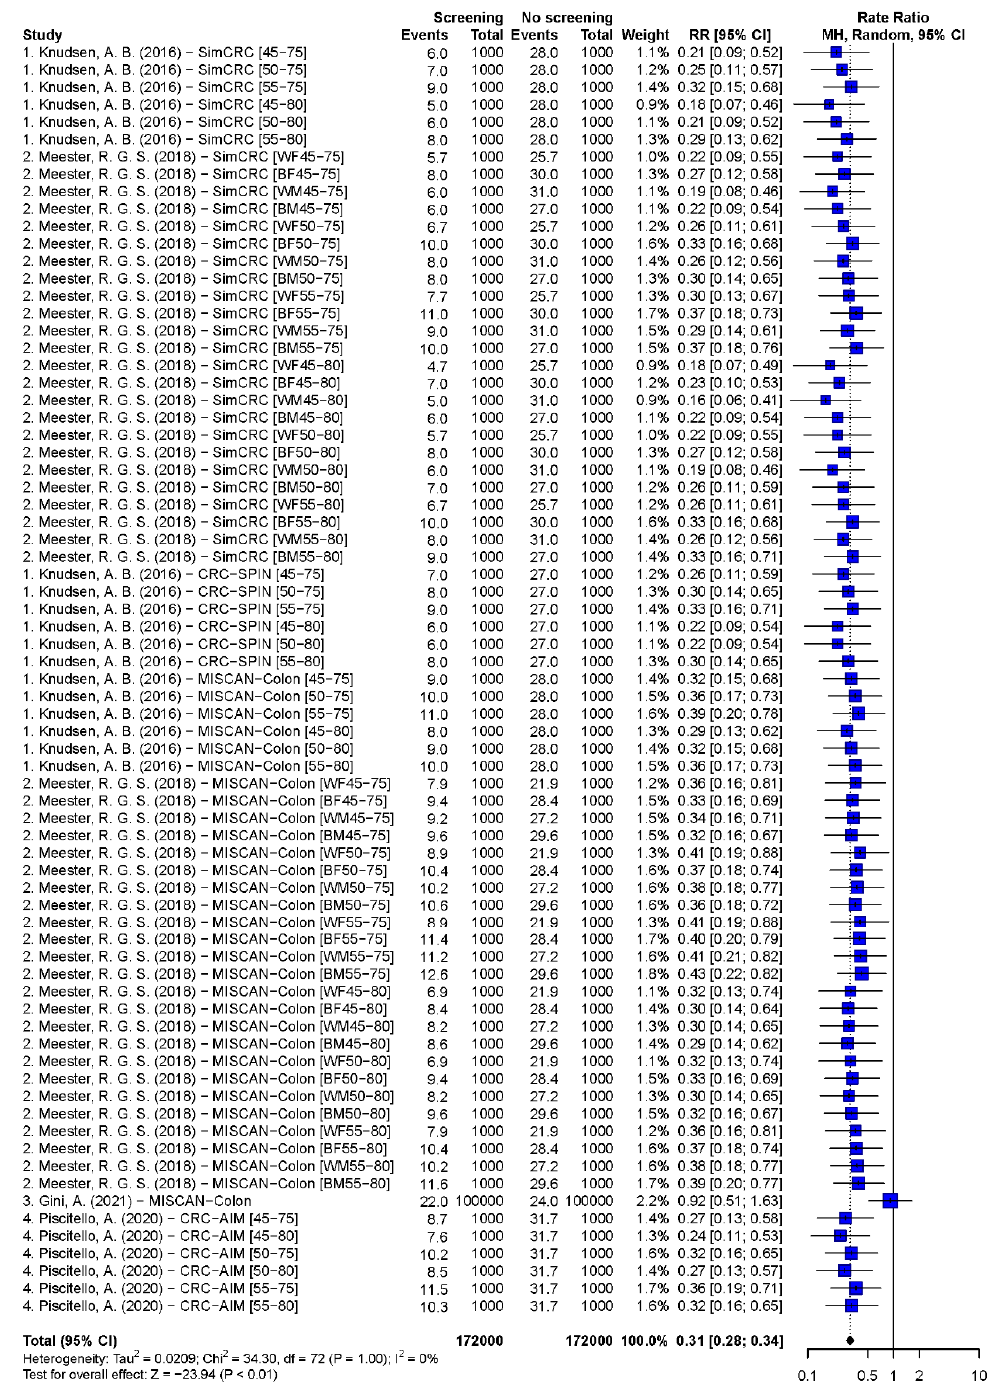
Figure 3. Forest plots of the CRC-specific mortality rate ratio on biennial gFOBT screening from the age of 45 to 80 [25,31,36,40].